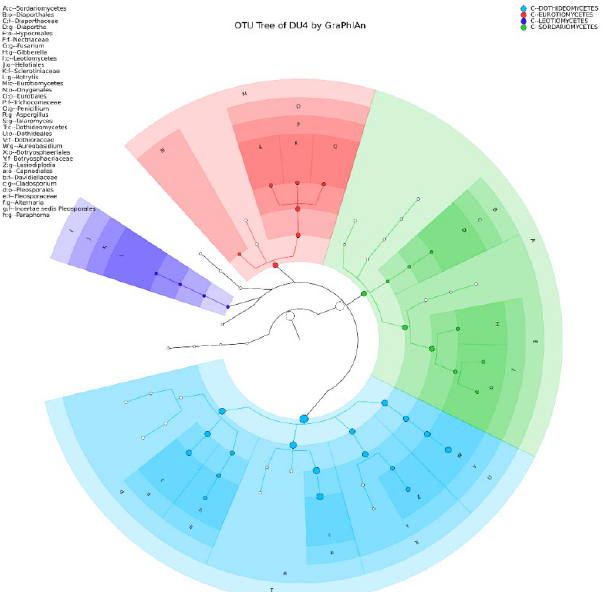
Fig. 1. Yeast diversity information of Lai durian ( Durio kutejensis ) collected from Desa Bukit Sawit, Central Kalimantan, Indonesia, using metagenomic approach based on ITS4 gene. Only Ascomycota was present and there are four large phylum exist with the domination of Sordariomycetes